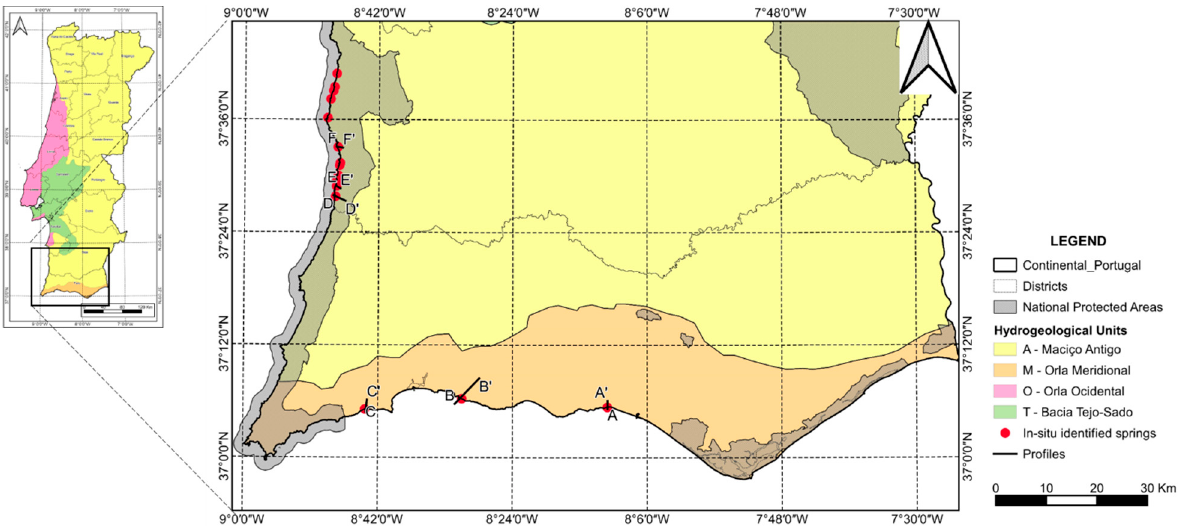
Figure 8. Potential Groundwater Discharge Springs identified in situ in South and Southwest Portugal.